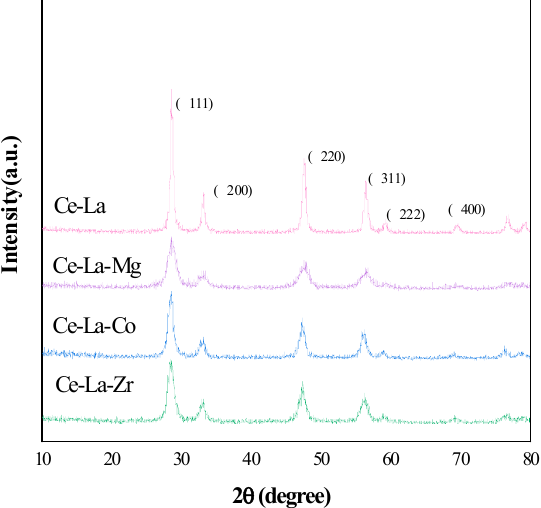
Figure 1. XRD patterns of metal ions doped on cerium lanthanum solid solution. Table 1. Structural and textural properties of Ce-La-M solid